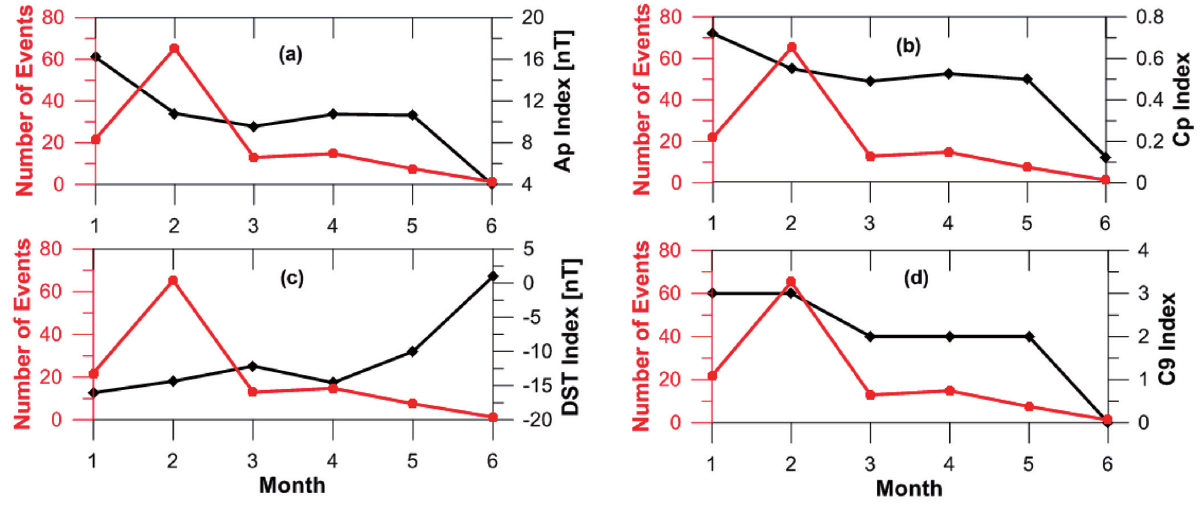
Figure 3. Comparison between the monthly VLF event occurrence rate and: (a) the Ap index; (b) the Cp index; (c) the Dst index; and (d) the C9 index, from January to June (months 1-6)